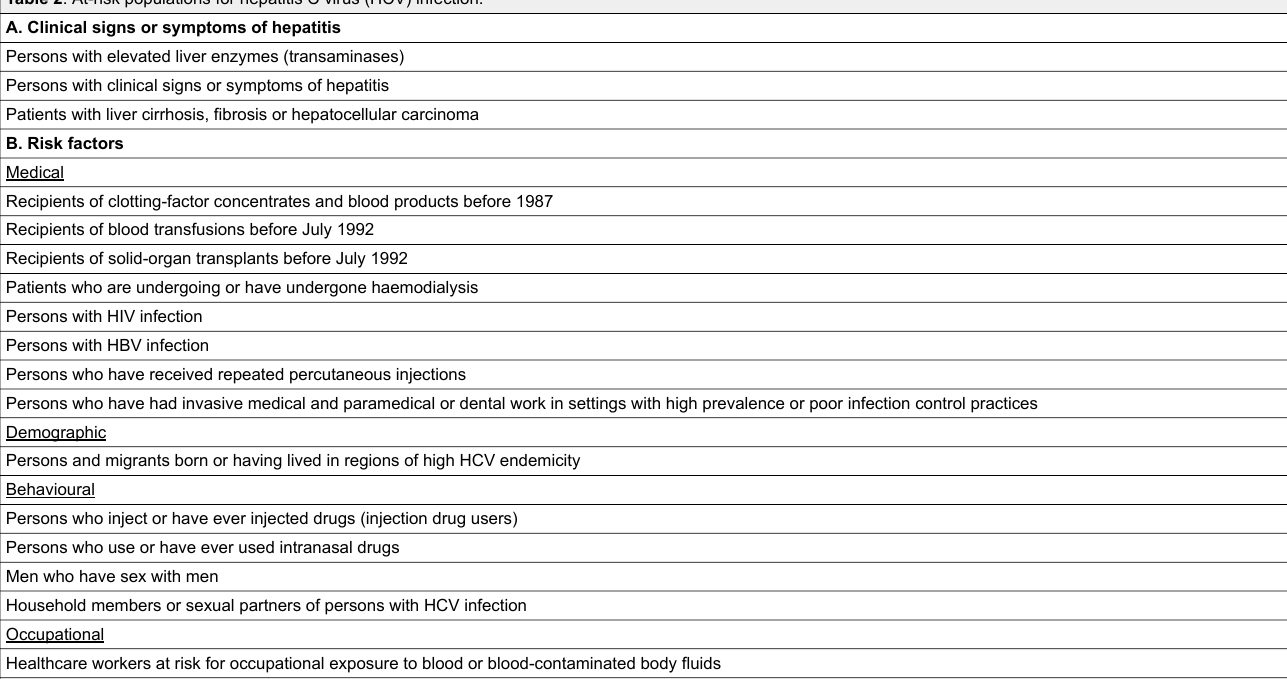
Table 2 : At-risk populations for hepatitis C virus (HCV) infection.